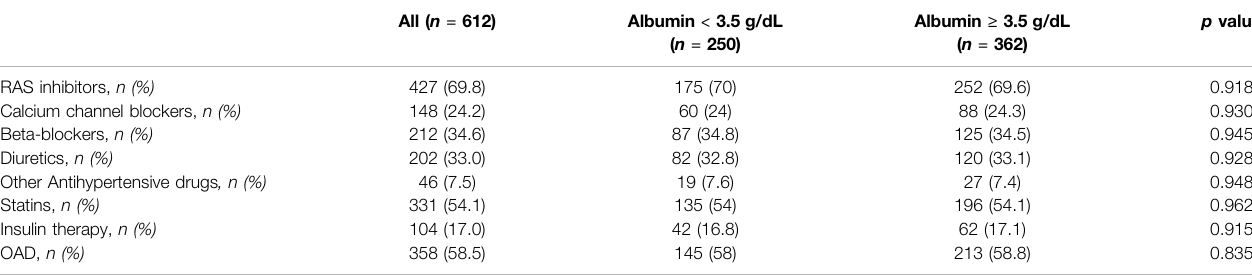
TABLE 2 | Drug treatment of the study population according to serum albumin levels.